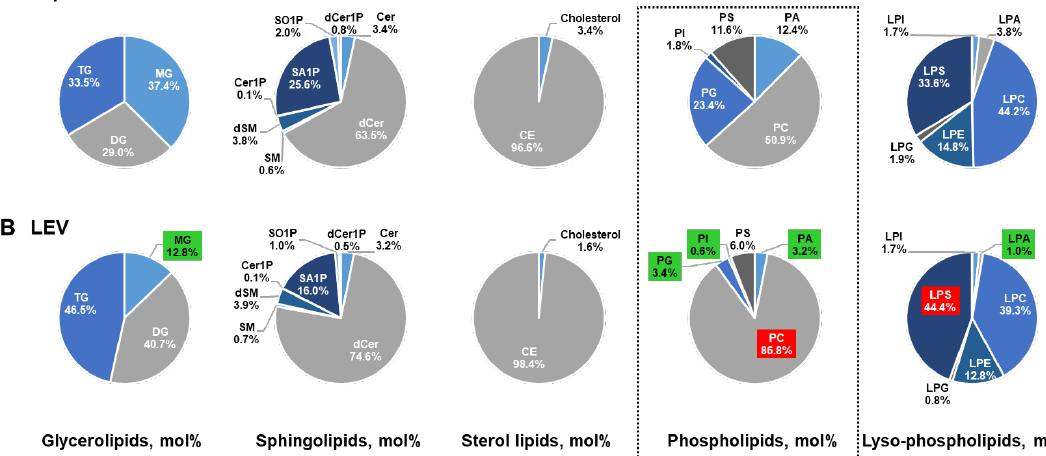
Figure 5. Lipid composition and proportion in L. plantarum versus LEVs. In pie diagrams for L. plantarum ( A ) and LEVs ( B ), the composition by lipid class (glycerolipids, sphingolipids, sterol lipids, phospholipids, and lyso-phospholipids) is expressed as a percentage of lipid category (mol% of lipid category) which was defined as the sum of the amount of identified lipid species (nmol / mg proteins). The markedly changed lipid classes in LEVs compared to L. plantarum are designated by red (increased) or green (decreased).